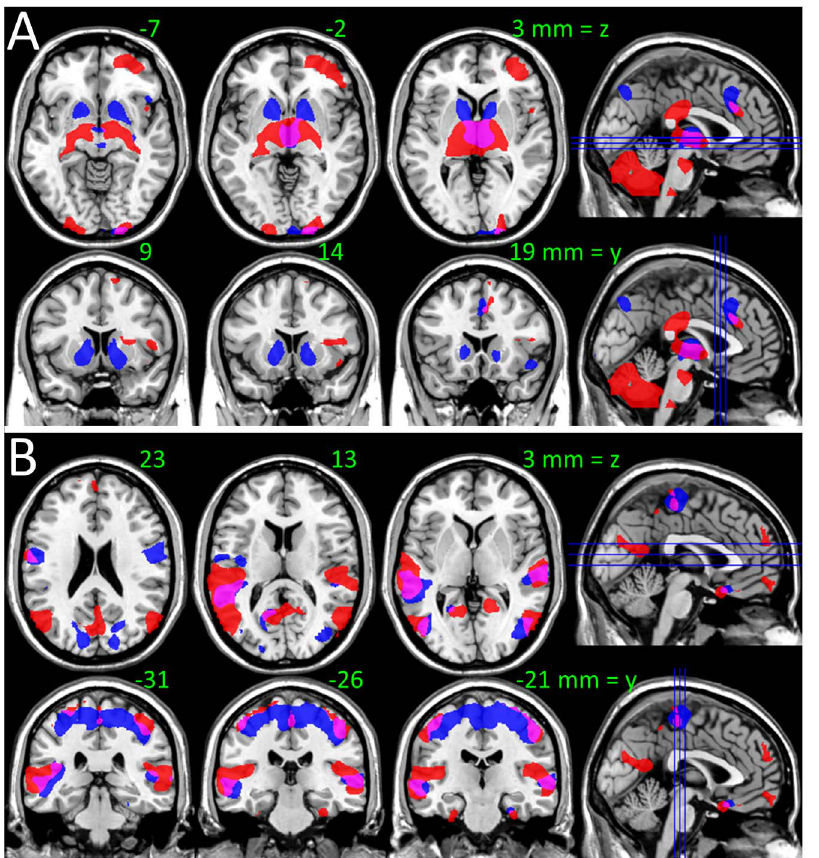
Figure 9. Overlapping hypo connectivity patterns for thalamus and midbrain in schizophrenia. Overlap and distinct patterns of hypo connectivity with thalamus (red) and SN (blue) for 69 schizophrenia patients versus 74 healthy controls at P , 0.001, superimposed on axial and coronal views of the human brain. The weaker positive (A) and negative (B) connectivity patterns overlap (pink) in thalamus, BAs 2–4, 6, 17–19, 21, 23, 24, 36, 37, 43 and differentiate in ventral striatum, putamen, pallidum (blue), cerebellum, BAs 10, 11, 32, 40 and 44–47